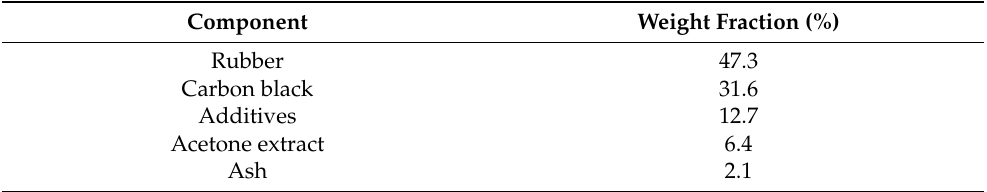
Table 1. Component of studied rubber